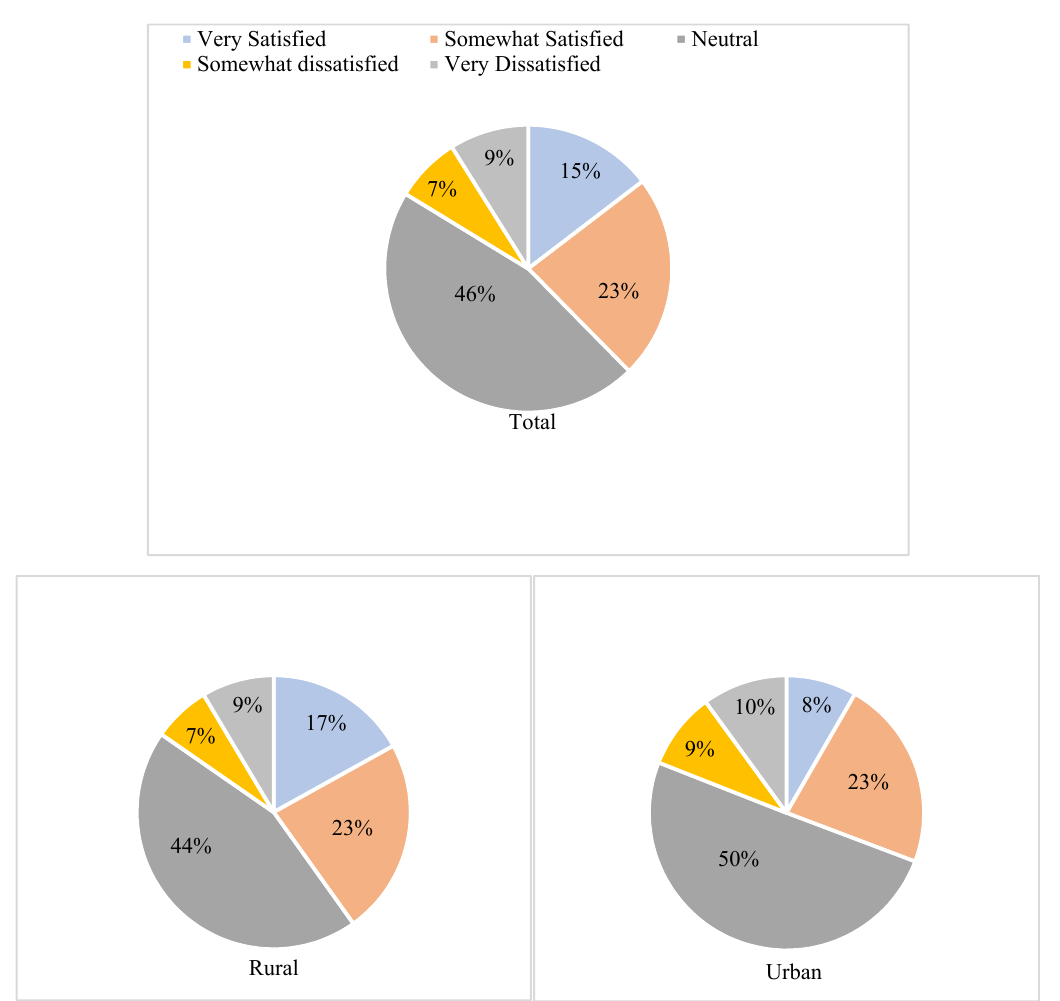
Figure 2. The distribution of participants’ attitude to local medical services.